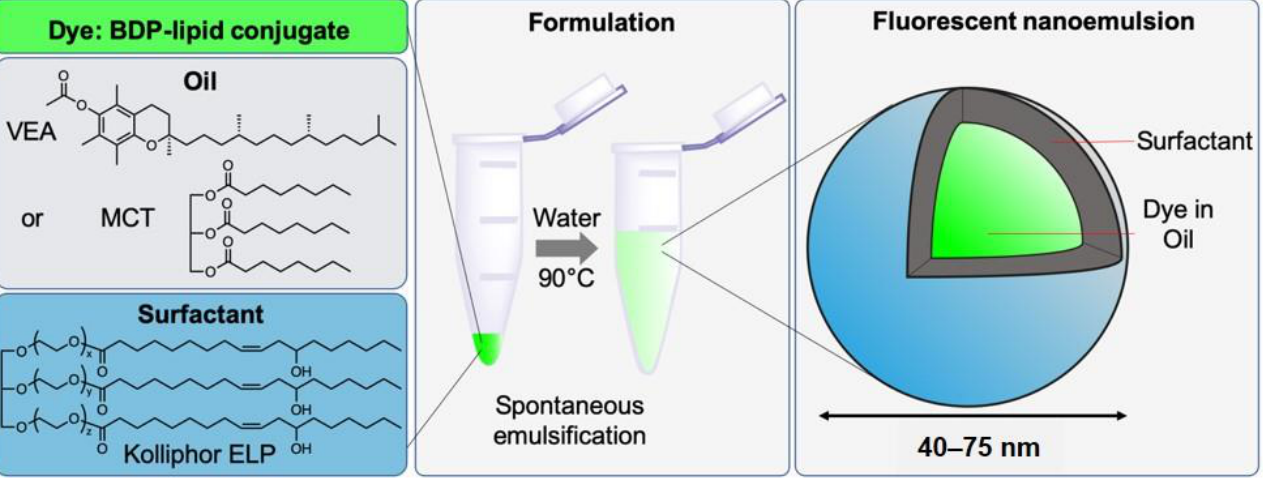
Figure 3. Composition and formulation of bright fluorescent NEs based on BDP-lipid conjugates.